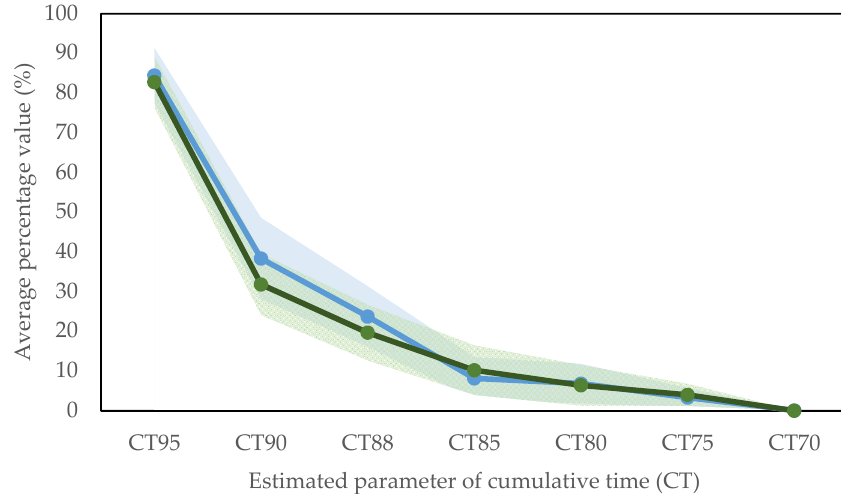
Figure 3. Mean and standard error bands for cumulative time percentages during the two walking tests for SpO 2 < 95% (CT95), SpO 2 < 90% (CT90), SpO 2 < 88% (CT88), SpO 2 < 85% (CT85), SpO 2 < 80% (CT80), SpO 2 < 75% (CT75), and SpO 2 < 70% (CT70). The blue coloured line represents the average values collected in the 6-minute walking test (6MWT) and the green coloured line represents the values measured in the 20-minute walking circuit (20MWC).